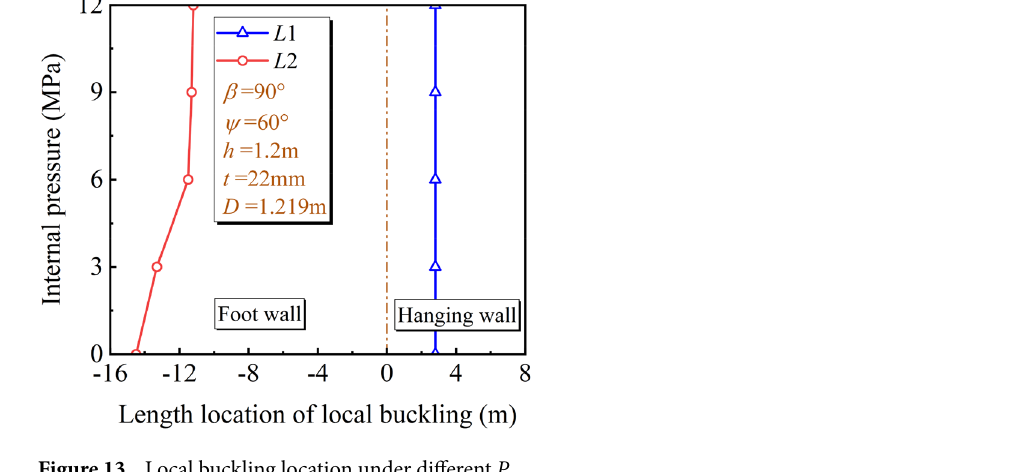
Figure 13. Local buckling location under different